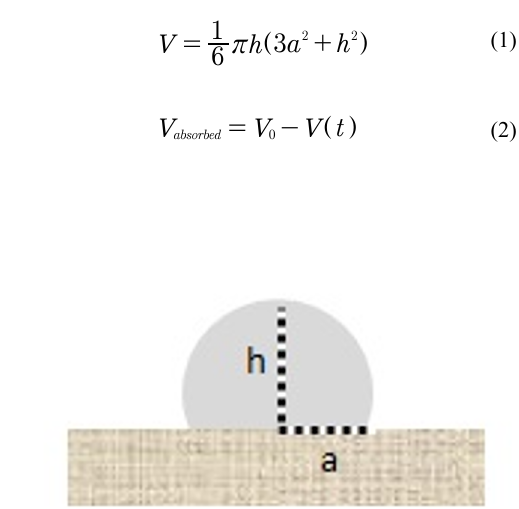
Figure 3. Schematic drawing of spherical cap of height (h) and radius (a), formed when a sessile drop reaches a fabric sample.